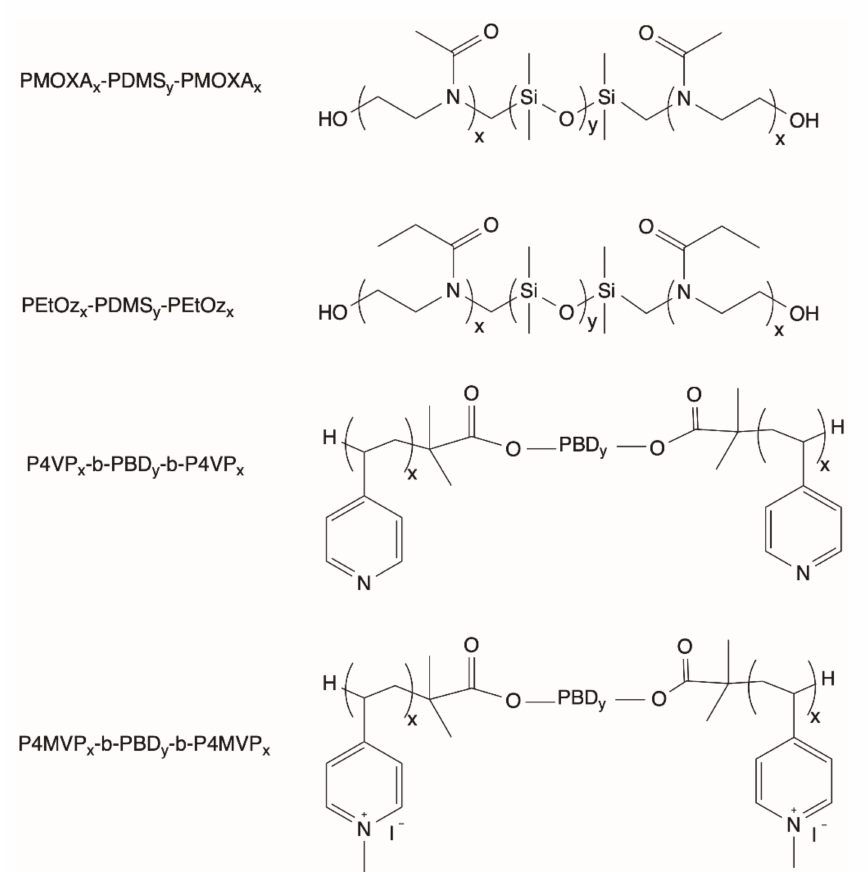
Figure 4. Structures of polymers that were used for the generation of polymersomes with photosynthetic activity. Abbreviations are listed in the footnote of Table 1. The